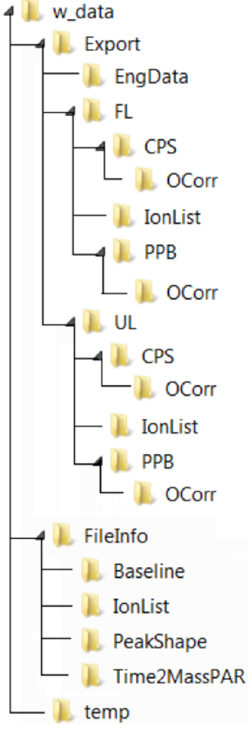
Figure A1. PTRwid file structure. Explanations are provided in the text of Appendix